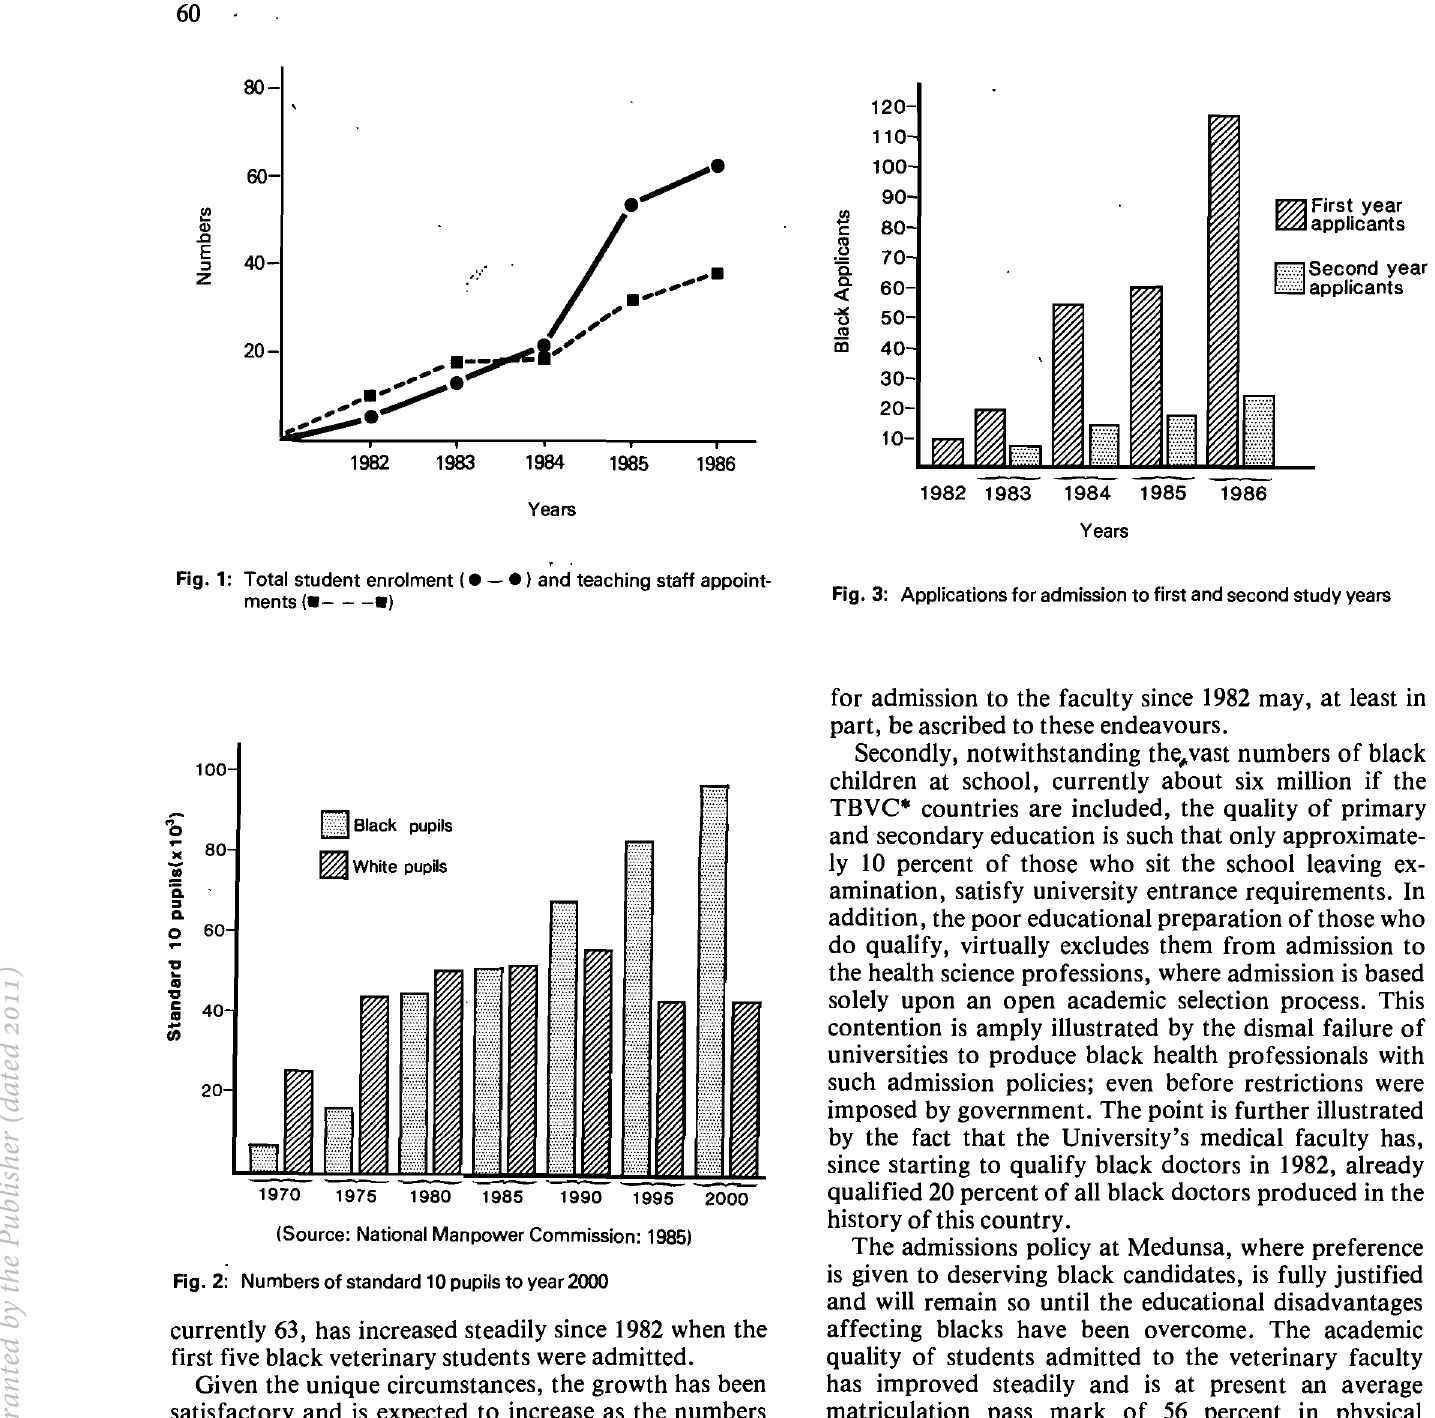
Fig. 1: Total student enrolment (. -.) and teaching staff appoint ments (.- - -.)